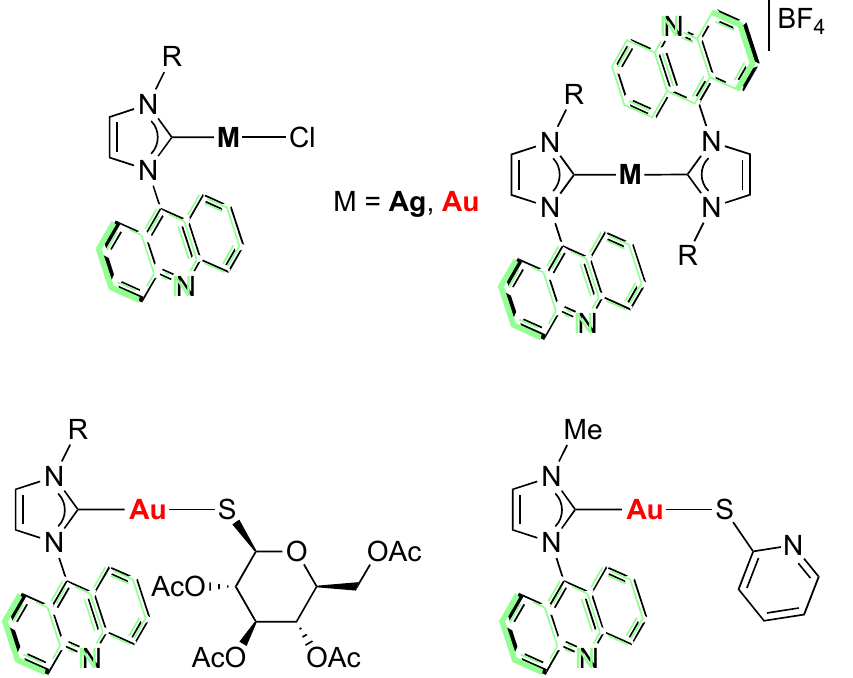
Figure 1. Acridine-based NHC complexes previously studied.